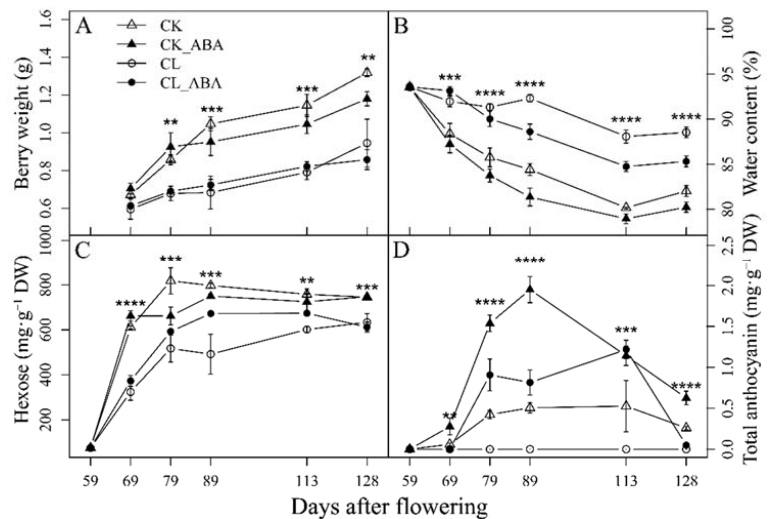
Figure 1. The effect of carbon limitation and exogenous ABA treatment on the berry fresh weight ( A ), water content ( B ), hexose concentration ( C ), and the total anthocyanins ( D ) during different developmental stages. CK: carbon sufficient; CL: carbon limitation; CK_ABA: carbon-sufficient and exogenous ABA treatment; CL_ABA: carbon limitation and exogenous ABA treatment. Vertical bars indicate SE ( n = 3). ** indicates p < 0.01; *** indicates p < 0.0001; and **** indicates p < 0.00001.